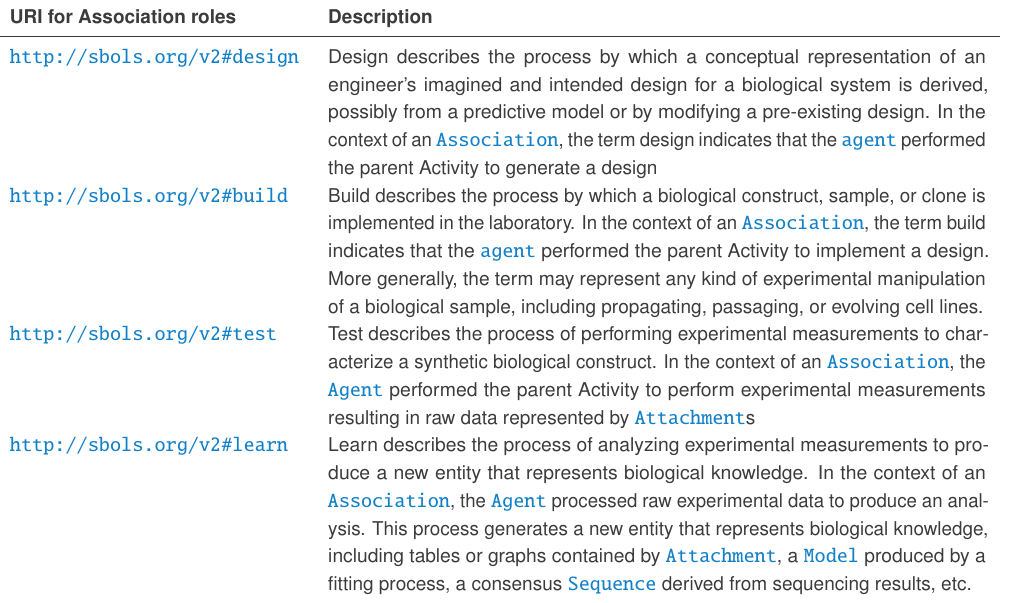
Table 18: Terms to specify the roles property of an Association